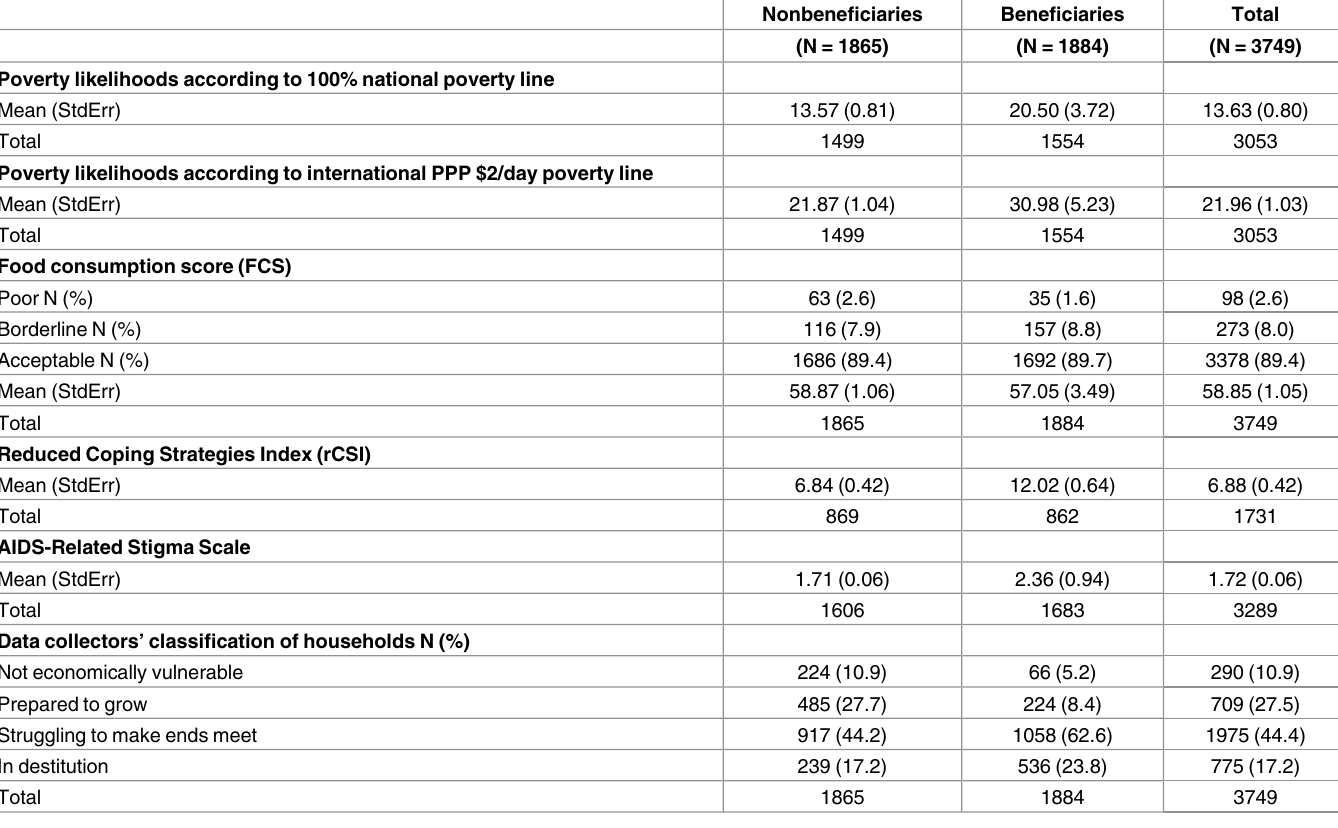
Table 6. Other vulnerability measures by USAID/PEPFAR beneficiary status.